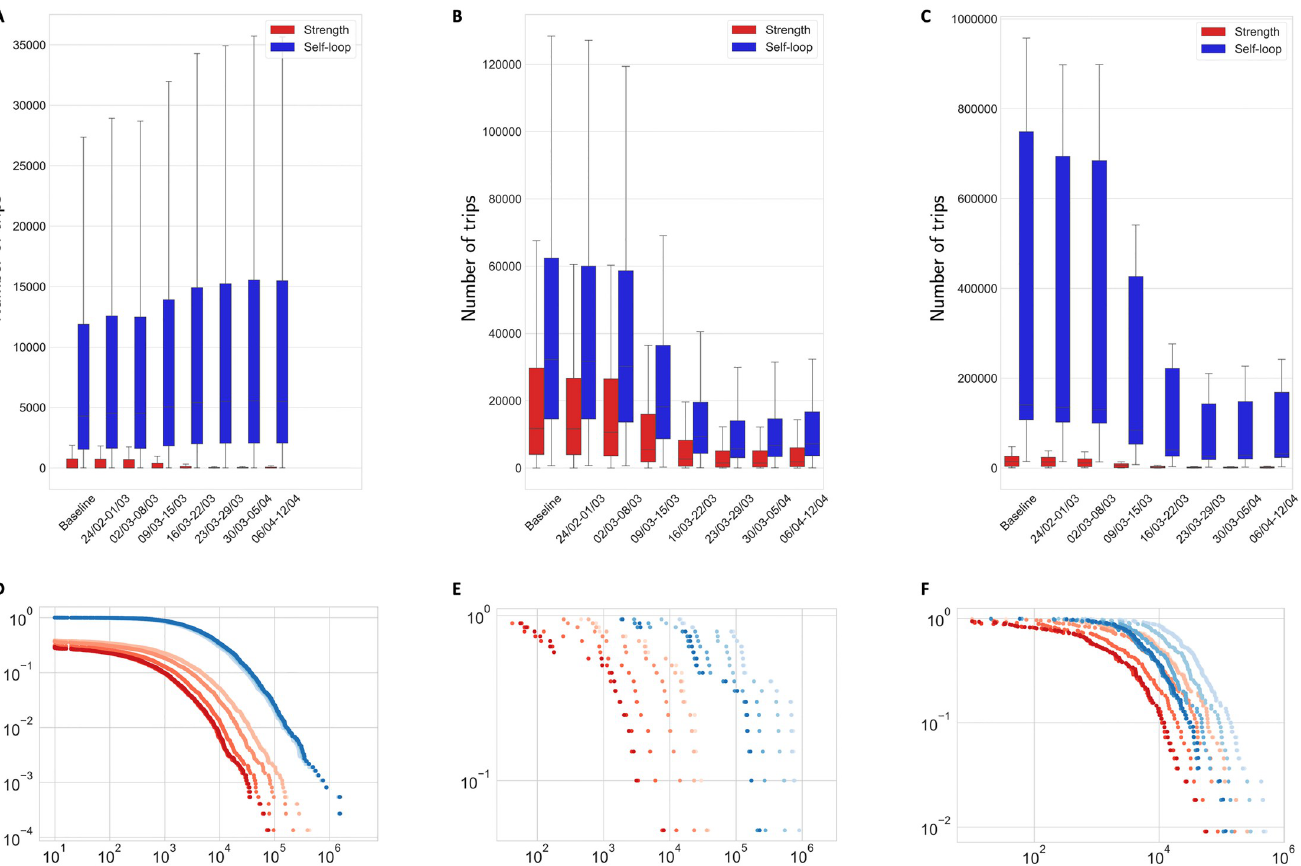
Fig 1. Mobility flows distribution at municipal, province and regional level. (A) and (D) show flows at municipal level, (B) and (E) show flows at province level and (C) and (F) show flows at regional level. Red indicates flows across administrative units, while blue stands for inner self-loops. In the top row we also show values for the “baseline” mobility network, which is built considering the average of daily observations over a window of 45 days prior to February 23rd. The bottom row shows the distribution of values for each week using a color scale that maps lighter colors to earlier periods. Application of one way ANOVA test between distributions of indicators in the 2nd and 3rd weeks (which capture the transition to national closure) are: Municipalities: Strength (Statistic = 27.50, PVAL * 0), Self-Loops (Statistic = 0.488, PVAL = 0.485); Provinces: Strength (Statistic = 3.92, PVAL = 0.049), Self-Loops (Statistic = 4.40, PVAL = 0.037); Regions: Strength (Statistic = 3.30, PVAL = 0.077), Self-Loops (Statistic = 1.50, PVAL = 0.223).